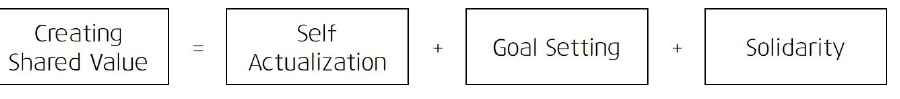
Figure 3. Study Model.